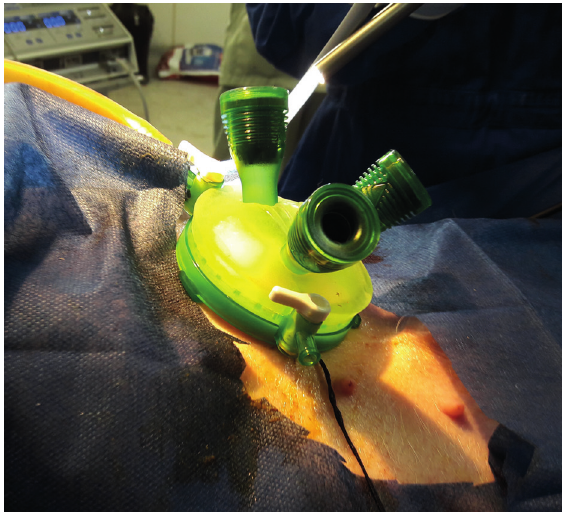
Figure 2 - Single-port Intragastric Sleeve in pigs - Positioning the single portal system (GelPoint, Applied Med. RS Margarita, CA,